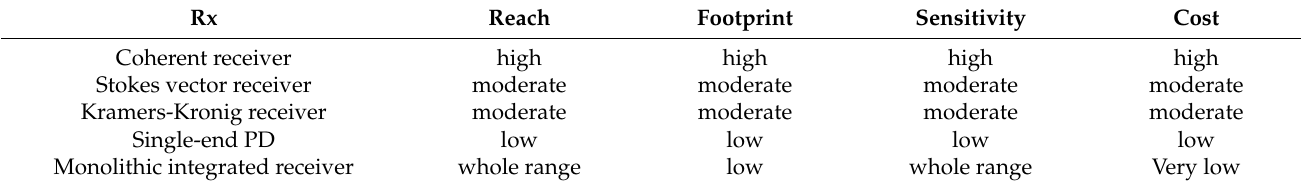
Table 7. Comparison of different receiver components applied in beyond 100-Gbit/s per lane data transmission.